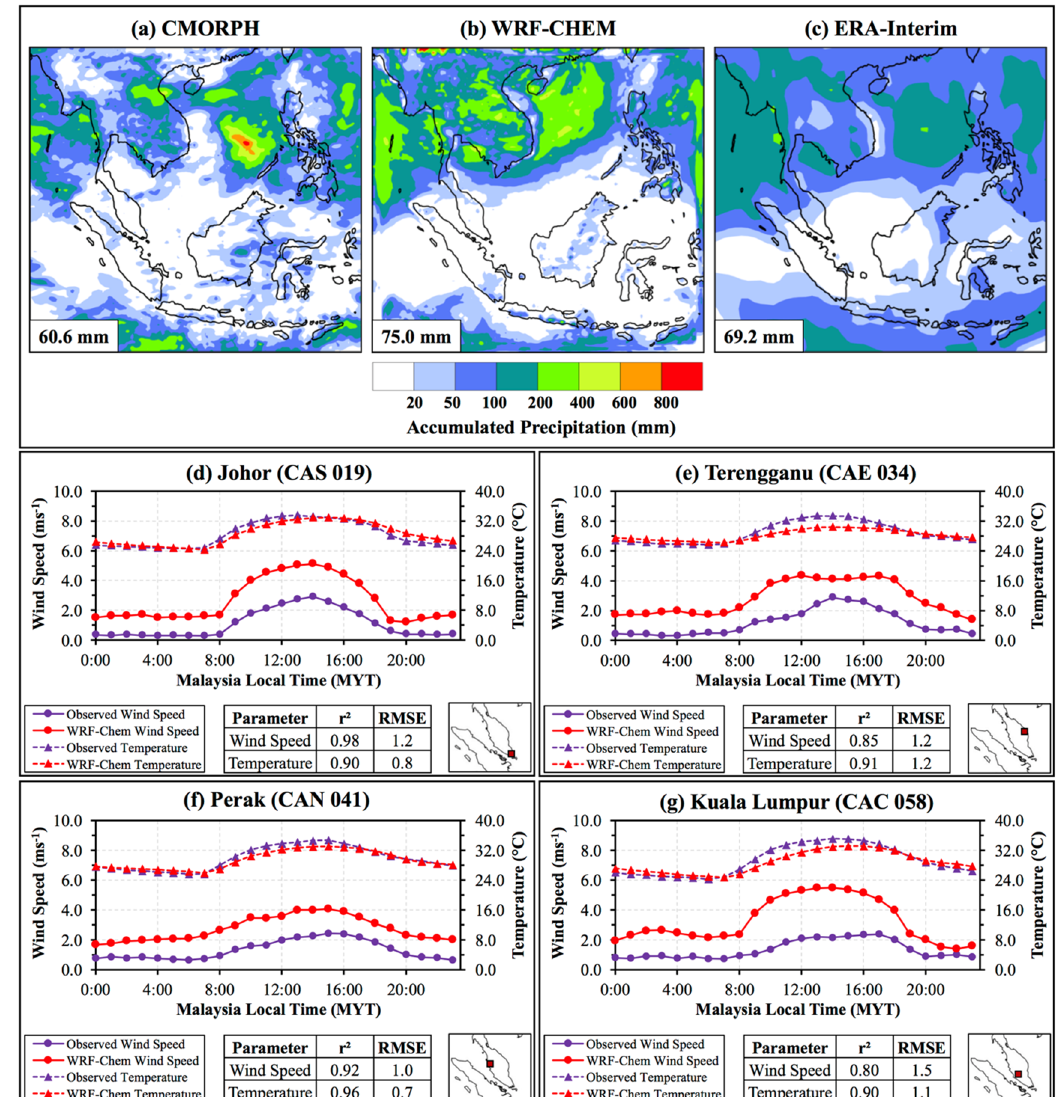
Figure 7. Meteorological evaluation for the period 17 to 25 June 2013. Co ‐ located accumulated precipitation (mm) from ( a ) CMORPH and ( b ) WRF ‐ Chem and ( c ) ERA ‐ Interim. Comparison of hourly averaged observed and model ‐ simulated 10 m wind speed (m s − 1 ) and 2 m temperature (°C) at ( d ) Johor, ( e ) Terengganu, ( f ) Perak, and ( g ) Kuala Lumpur. The solid red square on each inset map shows the location of each corresponding site.